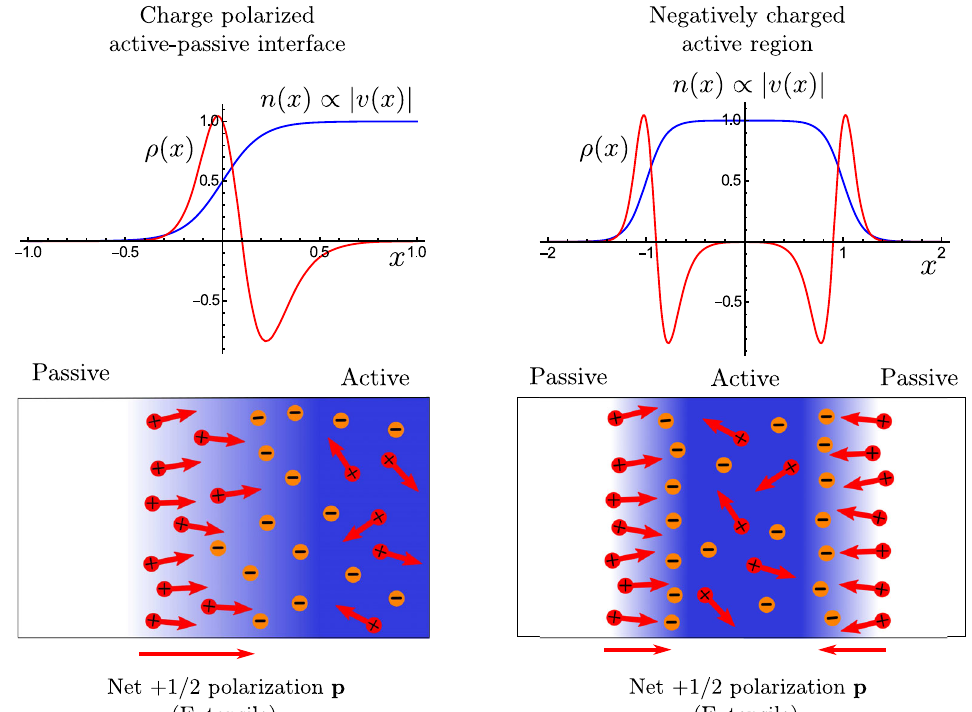
FIG. 5. The defect charge and number density along with the polarization in a 2D nematic with active-passive interfaces. The activity profile is simply chosen to be v ð x Þ ¼ ð v= 2 Þ½ 1 þ tanh ð 2 x=w Þ(cid:3) for a passive ( x < 0 ) to active ( x > 0 ) interface, v being the maximum activity and w the width of the interface. As can be seen, the interface develops a steady-state charge polarization, with excess þ 1 = 2 disclinations near the passive side and a compensating number of − 1 = 2 disclinations near the active side. Within the bulk active region with isotropic defect chaos, the polarization vanishes, but at the interface, the þ 1 = 2 disclinations locally order to orientationally polarize the interface as well. The direction of interfacial polarization is shown in the cartoon for the extensile case ( v < 0 ), with the defects just marked by the sign of their topological